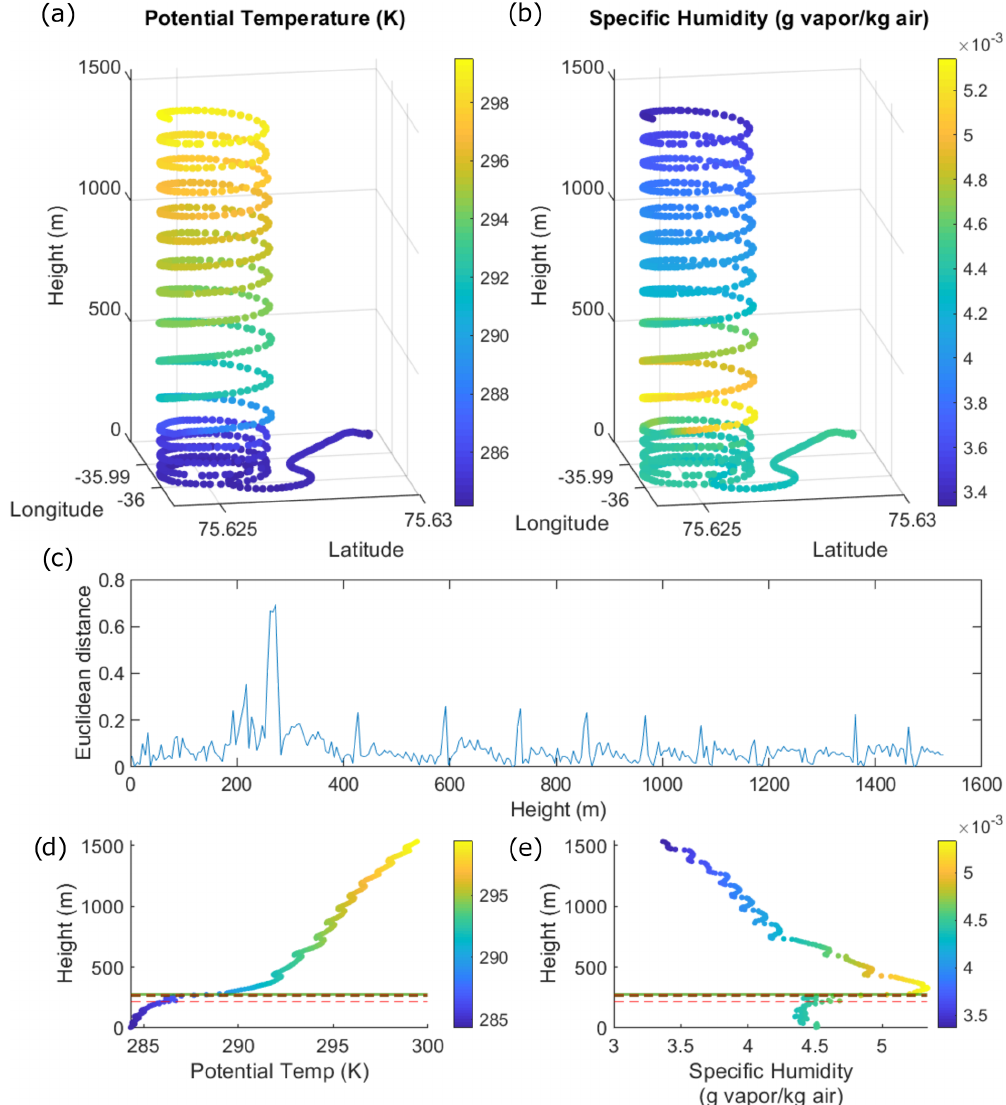
Figure 7. The ascension profile for the 12 June flight mission available to the operator to determine PBL location. The flight path reached a maximum altitude of ∼ 1500ma . g . l . ( a and b ). The potential candidate for the Euclidean distance determination of the PBL is shown to be at approximately 272.5ma . g . l . (c) . The top three candidates for PBL all correspond to approximately the same location (green and dotted lines d–e ). There is a modest gradient in potential temperature over the flight path of about 16 ◦ K (d) . Specific humidity shows an inversion in the first few hundred meters of flight at the determined location of the PBL (e)